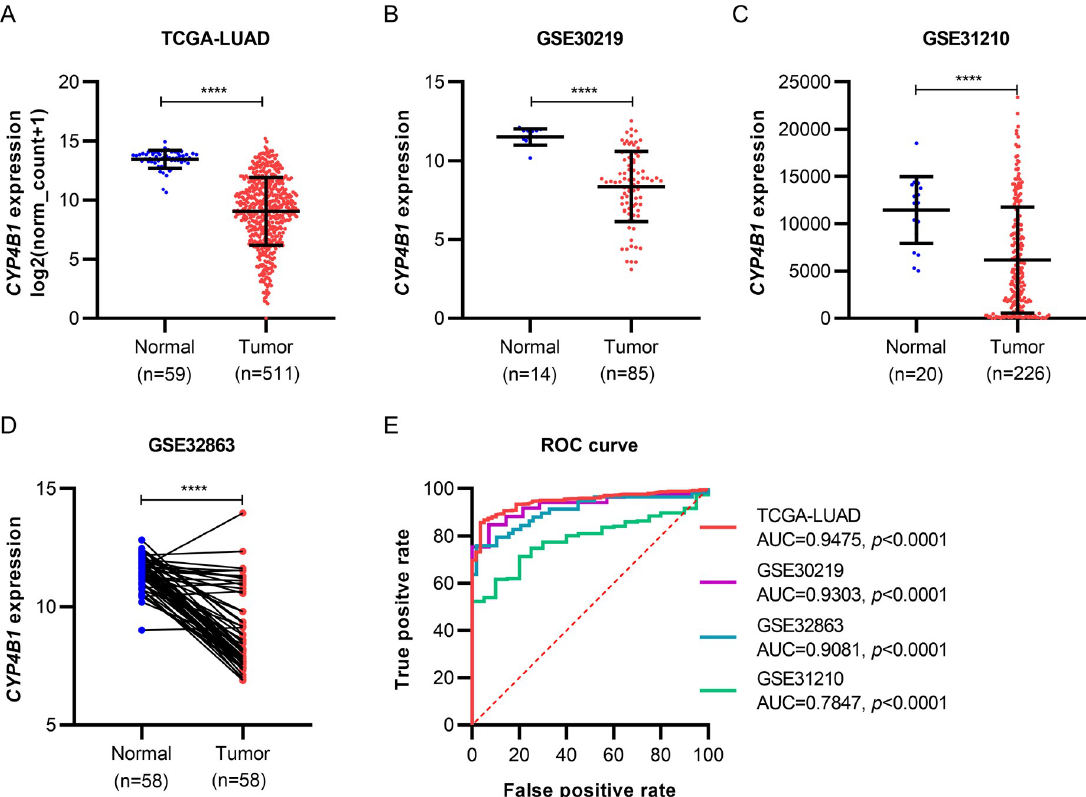
Fig 1. CYP4B1 mRNA expression profiles in patients with LUAD from TCGA and GEO dataset cohorts. (A–D) CYP4B1 mRNA expression in LUAD tissues and normal controls from a TCGA cohort (A), GSE30219 cohort (B), GSE31210 cohort (C) and GSE32863 cohort (D). (E) ROC curves showing the diagnostic value of CYP4B1 in LUAD (red curve, data from TCGA cohort; purple curve, data from GSE30219 cohort; blue curve, data from GSE32863 cohort; green curve, data from GSE31210 cohort). ���� p < 0.0001. LUAD, lung adenocarcinoma; TCGA, The Cancer Genome Atlas; GEO, Gene Expression Omnibus; ROC, receiver operating characteristic.